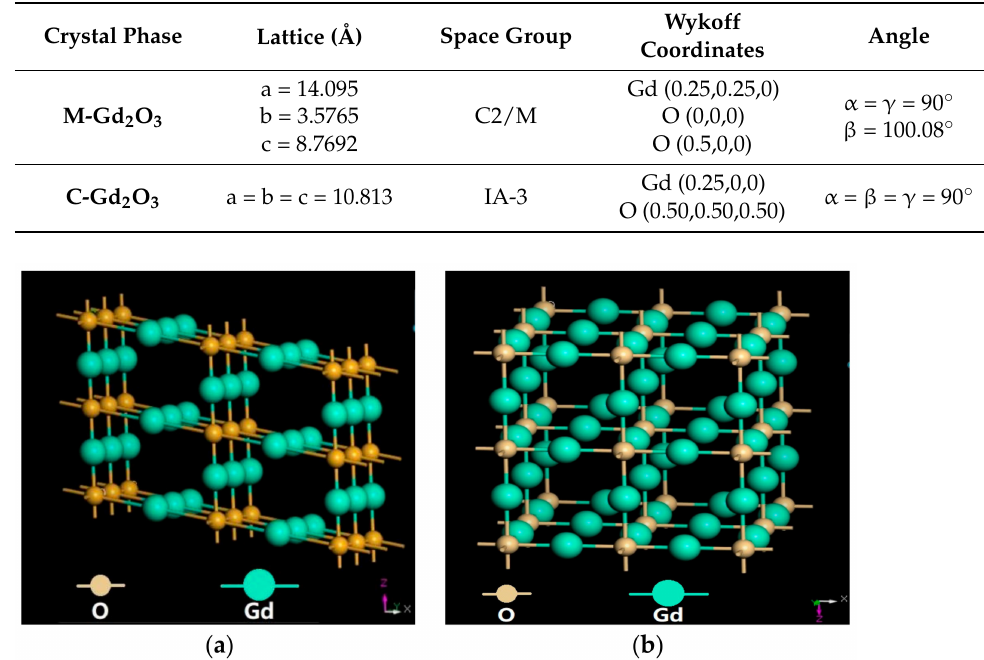
Figure 9. Crystalline structures of the Gd 2 O 3 : ( a ) M-Gd 2 O 3 , ( b ) C-Gd 2 O 3